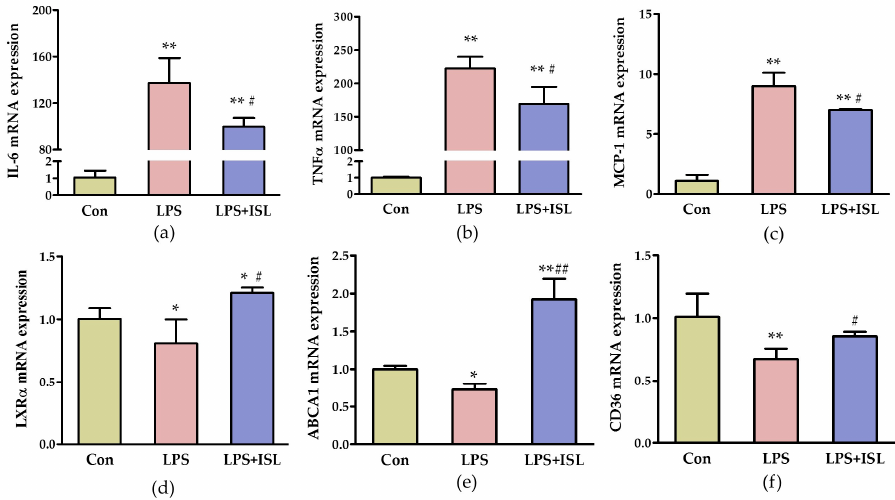
Figure 1. Isoliquiritigenin (ISL) reduced lipopolysaccharide (LPS)-induced inflammatory response and increased the expression of genes involved in cholesterol homeostasis in macrophages. The mRNA levels of inflammation-associated cytokines interleukin 6 ( IL-6 ) ( a ); tumor necrosis factor α ( TNF- α ) ( b ); monocyte chemotactic protein-1 ( MCP-1 ) ( c ); and lipid flux-related receptors liver X receptor α ( LXR α ) ( d ); ATP-binding cassette transporter A1 ( ABCA1 ) ( e ); and cluster of differentiation 36 ( CD36 ) ( f ) were determined using qPCR. Peritoneal macrophages from apolipoprotein E-deficient (apoE − / − ) mice were treated with LPS (50 ng/mL) and ISL (0.1 μ g/mL) for 6 h. Total RNA was extracted and reverse transcribed into cDNA ( n = 3–4; * p < 0.05, ** p < 0.01 vs. control group, # p < 0.05, ## p < 0.01 vs. LPS-induced group).